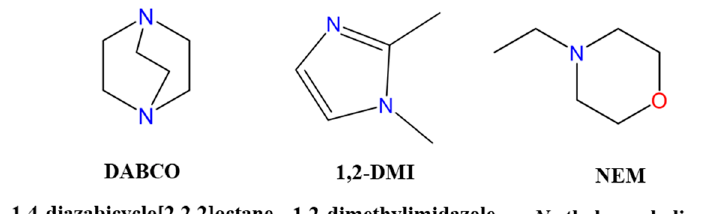
Figure 1. Chemical structures of the studied catalysts.